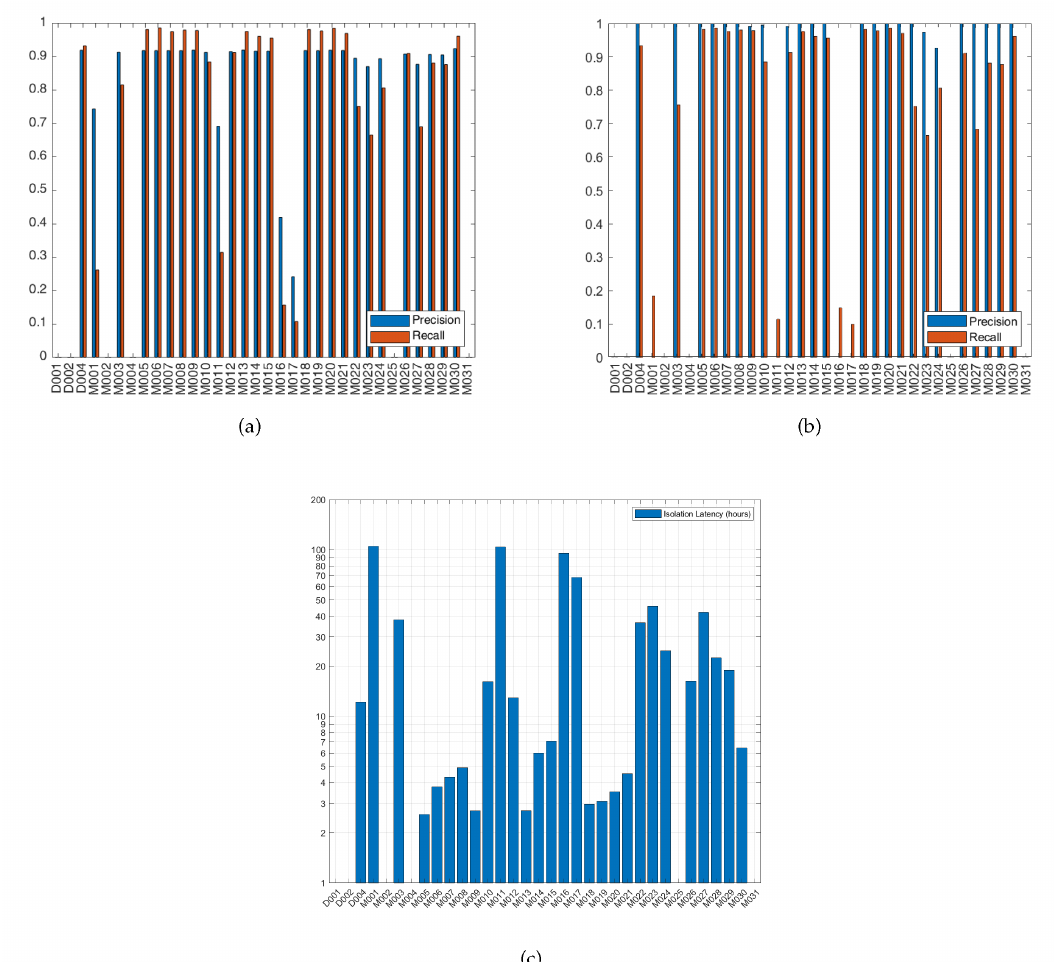
Figure 10. Obstructed-View (5 days) Failure: ( a ) Precision and recall of failure detection. ( b ) Precision and recall of failure isolation. ( c ) Failure isolation